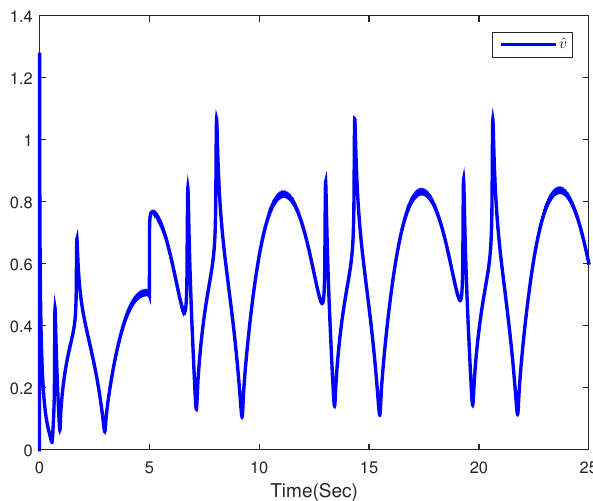
Figure 7. The curves of ˆ σ 1 and ˆ σ 2 (Case 2).